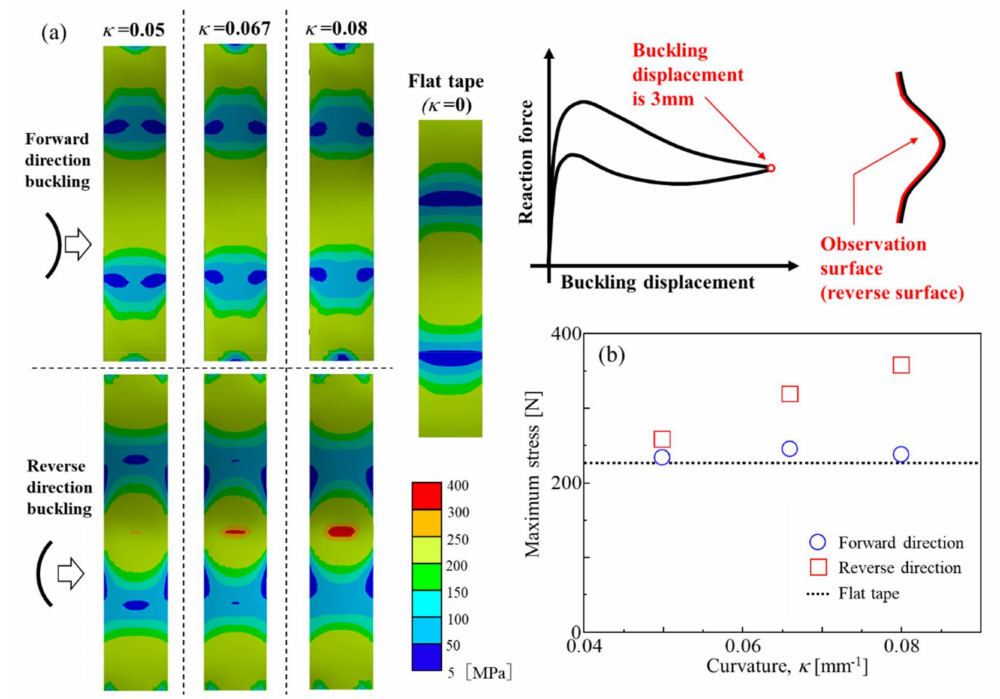
Figure 15. The numerically obtained ( a ) stress distribution and ( b ) κ dependence of maximum stress on the reverse surface of each specimen for each buckling direction, when the buckling displacement is 3